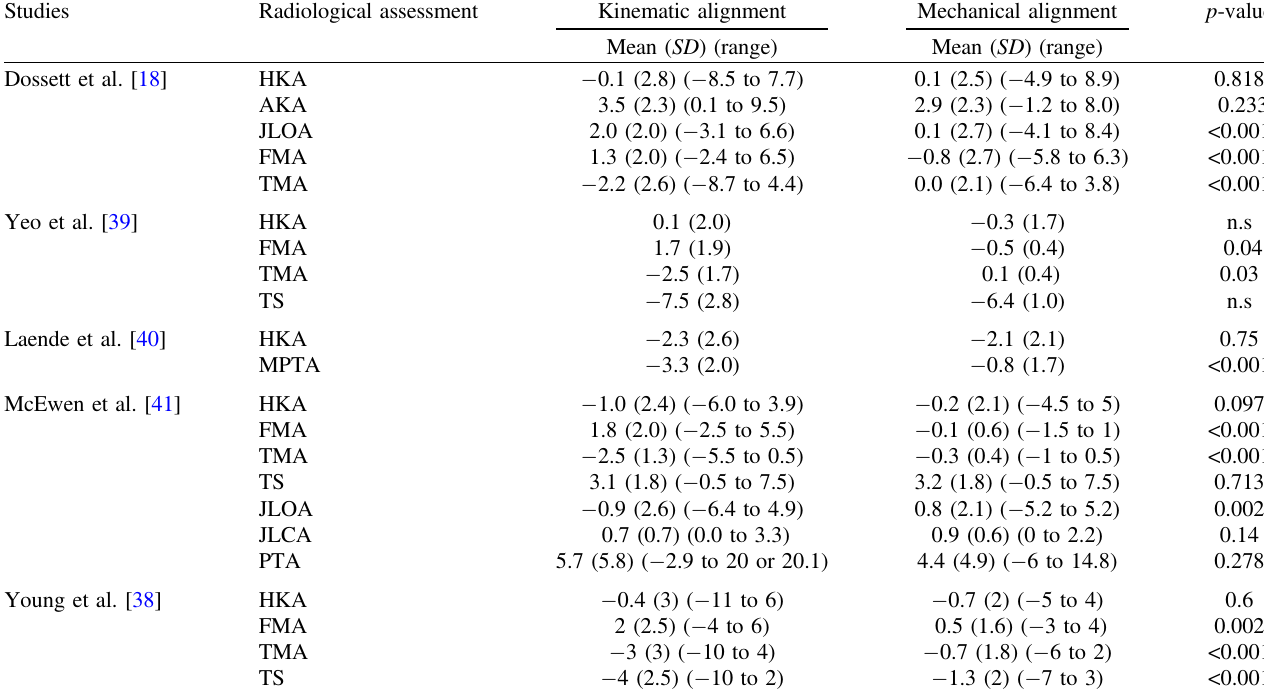
Table 4. Radiological results at the last follow up ( SD = standard deviation).